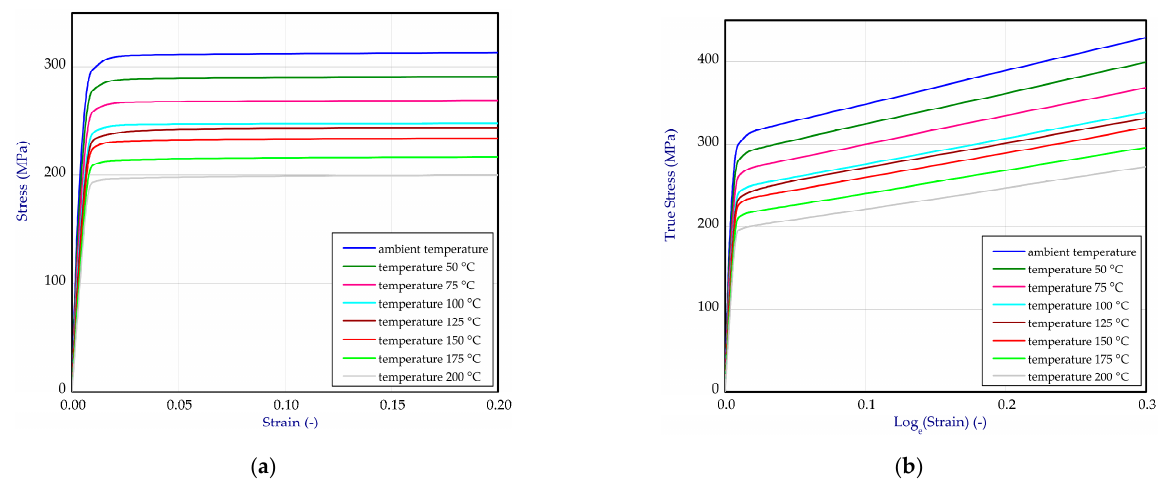
Figure 4. The tensile curves of aluminum alloy ( a ) and curves after transformation into true stress-logarithmic strain relation ( b ).